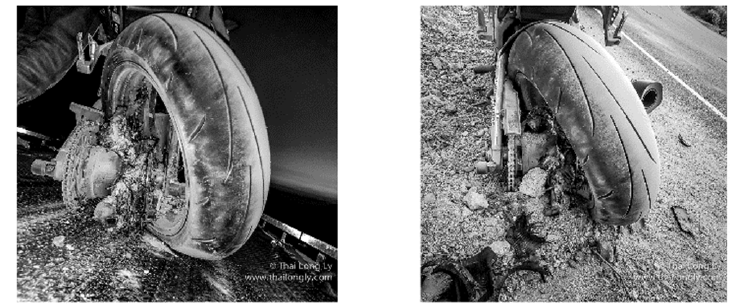
Figure 5. CF wheel failure [14].